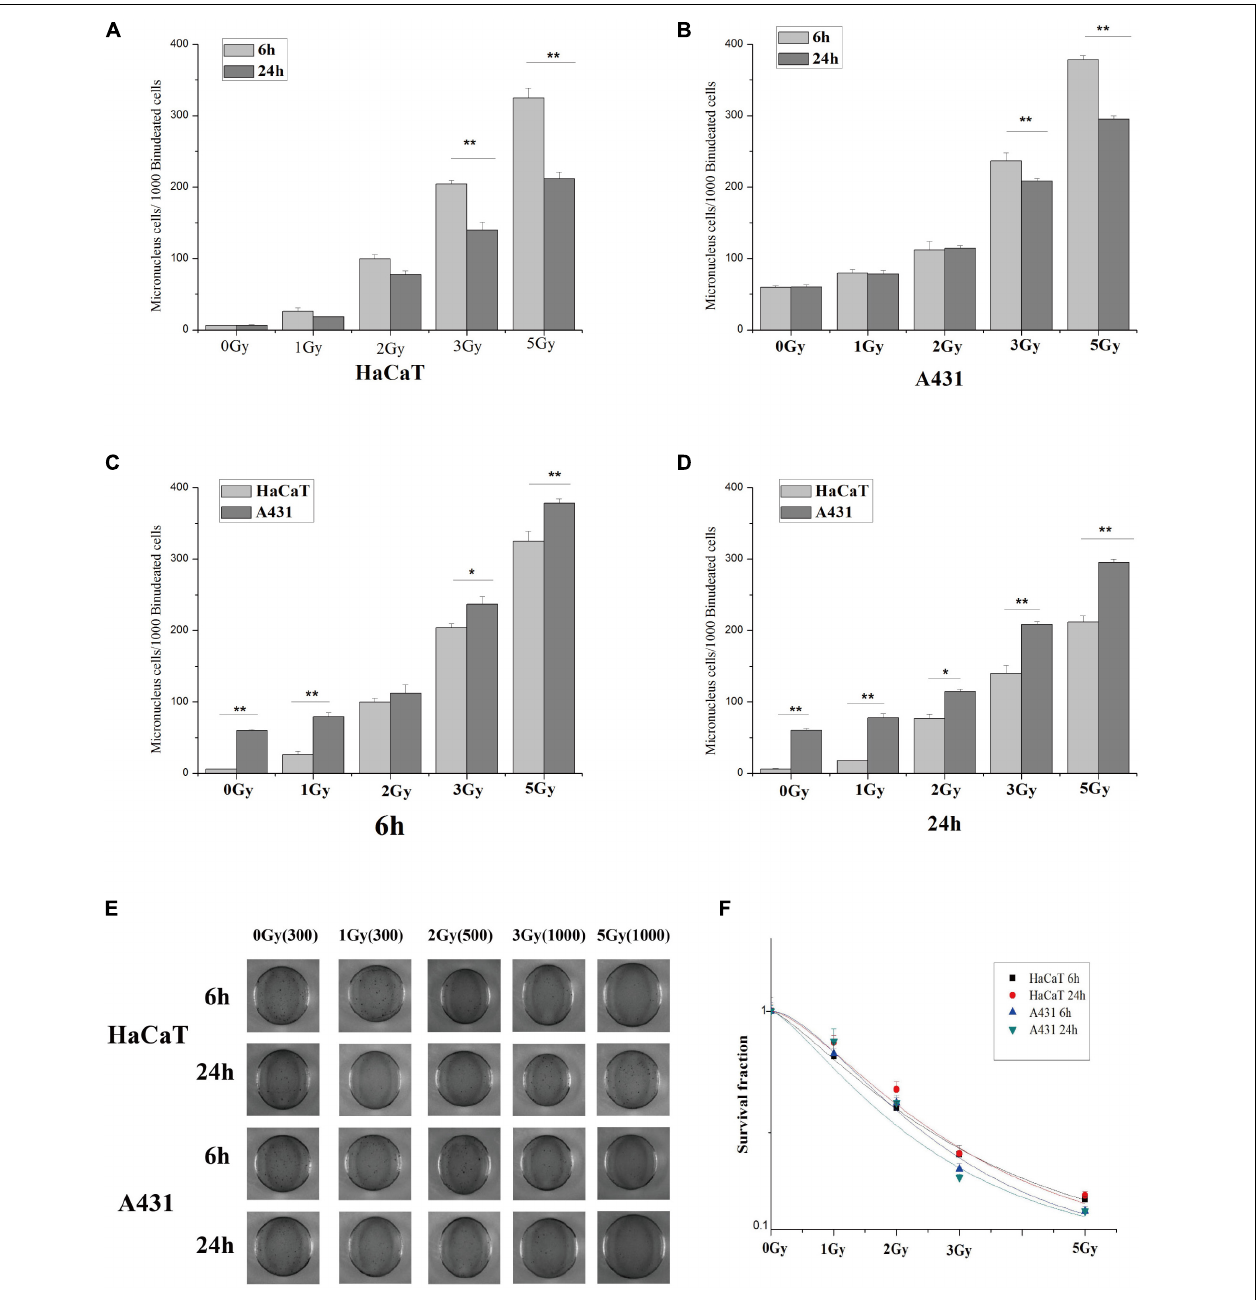
FIGURE 2 | Statistical analysis and schematic diagrams of micronuclei and clone formation assays in irradiated A431 and HaCaT cells. (A) Comparison of micronuclei formation in HaCaT cells 6 and 24 h after irradiation. (B) Comparison of micronuclei formation in A431 cells 6 and 24 h after irradiation. (C) Comparison of micronuclei formation in HaCaT and A431 cells 6 h after irradiation. (D) Comparison of micronuclei formation in HaCaT and A431 cells 24 h after irradiation. (E) Schematic diagram showing micronuclei formation in HaCaT and A431 cells 6 and 24 h after irradiation. (F) Dose-survival curves for HaCaT and A431 cells 6 and 24 h after irradiation. D 0 (HaCaT 6 h) = 2.84403, N = 1.32932; D 0 (HaCaT 24 h) = 2.49758, N = 1.6035; D 0 (A431 6 h) = 2.10442, N = 1.82945; D 0 (A431 24 h) = 2.29352, N = 1.38693. * p < 0.05, ** p < 0.01 between the two cell